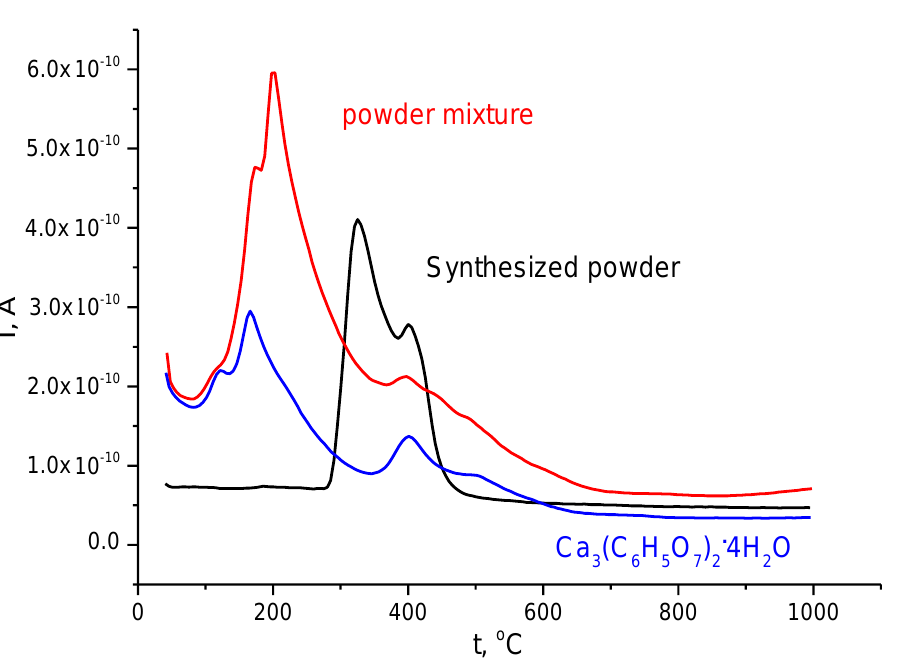
Figure 5. Mass spectra for evolving gases with m/Z = 18 for synthesized powder (in black), calcium citrate tetrahydrate Ca 3 (C 6 H 5 O 7 ) 2 ·4H 2 O (in blue), and their powder mixture (in red). Table 1. Comparison of mass spectra data for synthesized powder, calcium citrate